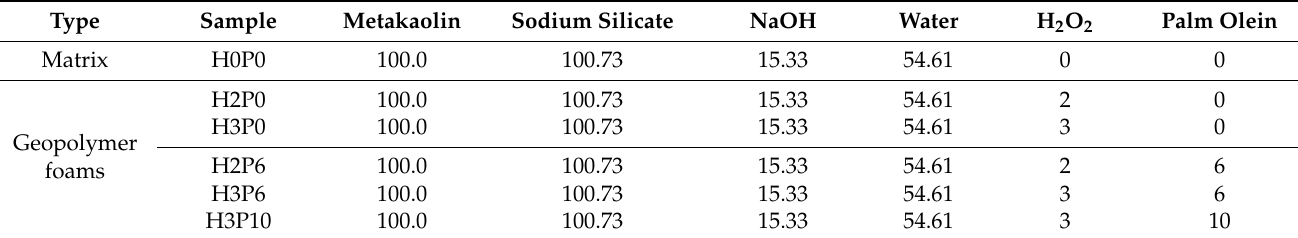
Figure 3. Fabrication process of geopolymer foams. Table 2. Mix proportions of the samples (g).